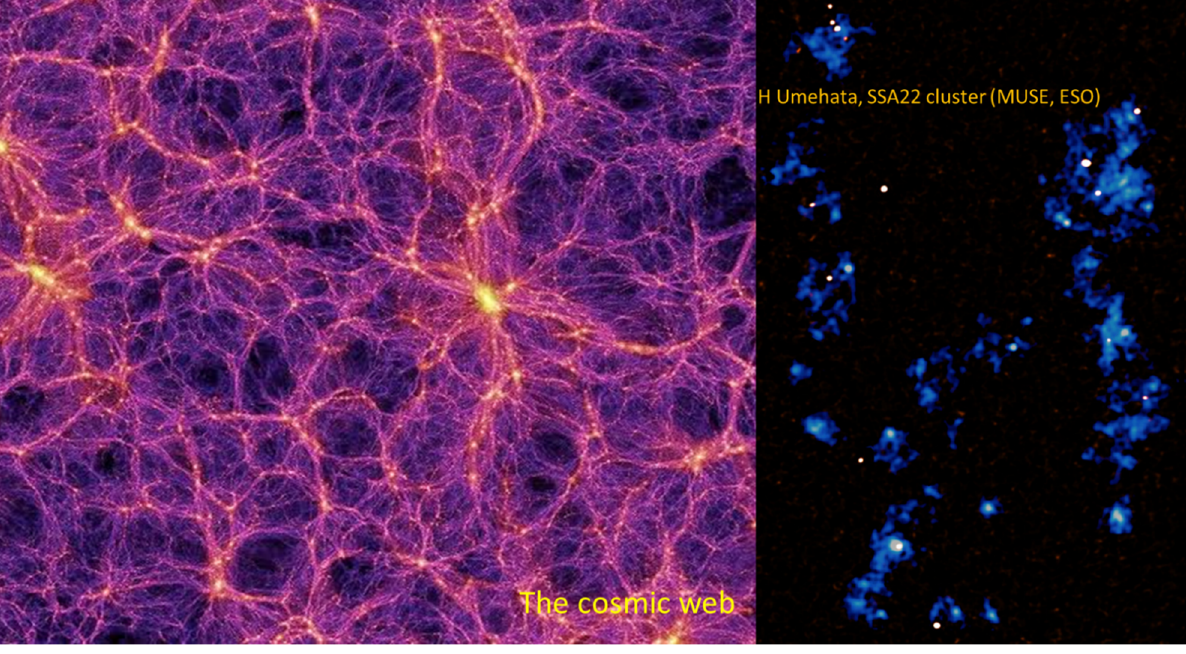
Figure 7. Artistic representation of the two ESA missions Planck and Euclid put together for visual comparison.